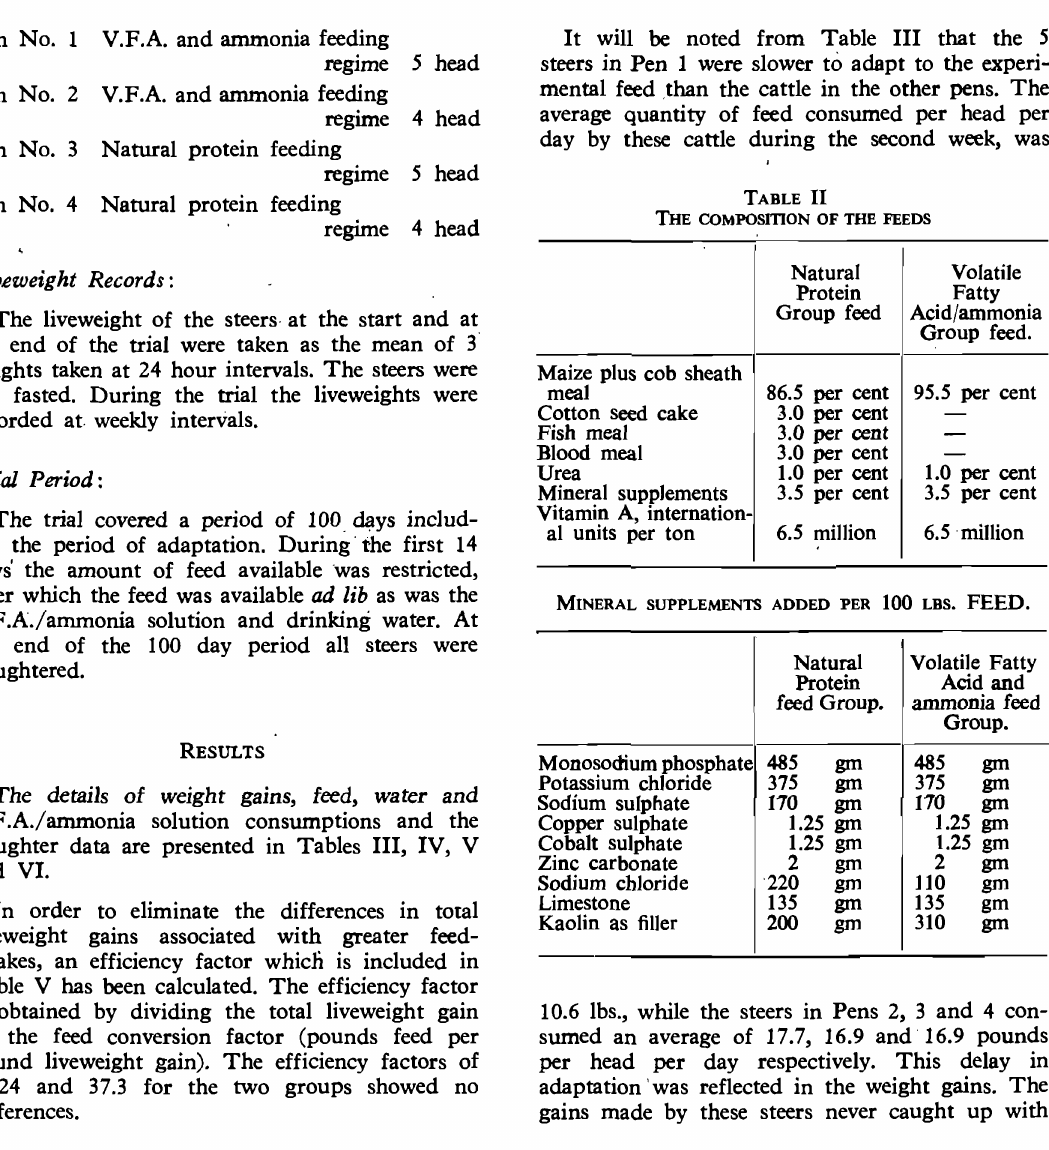
TABLE I.-THE COMPOsmON OF THE VOLATILE FATIY ACID